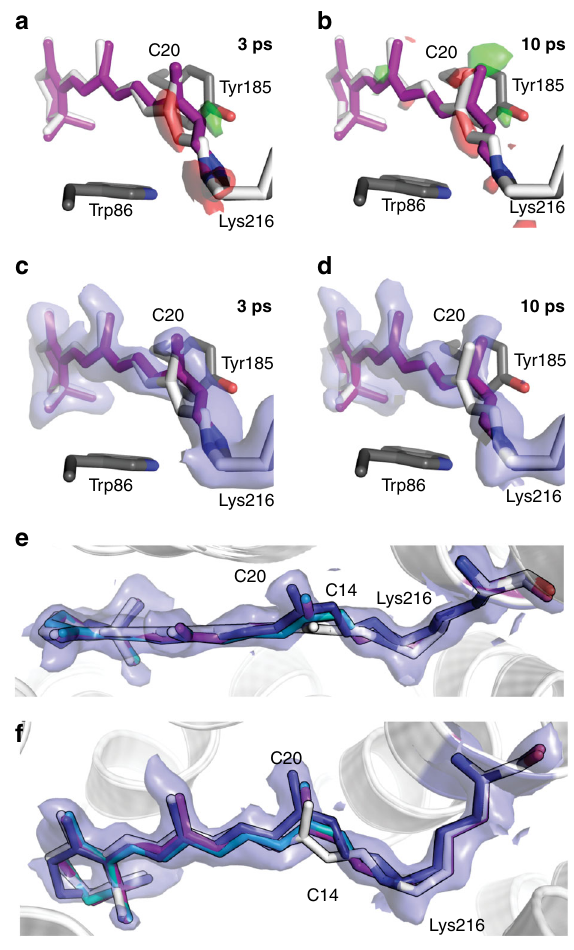
Fig. 5 Structure of the retinal in bacteriorhodopsin on the ps timescale. a View along retinal at time delays of 3 ps ( a , c ) and 10 ps ( b , d ); the retinal is shown in purple and the dark-state structure as white sticks. Extrapolated electron difference maps (green, + 3 σ and red, − 3 σ ) show clear deviations from the dark-state structure at the C20 methyl group as well as around the C13 = C14 bond. Both the C20 methyl group and the C14 atom shift towards residue Tyr185 (shown as grey sticks). The 10-ps structure was re fi ned using geometric parameters from a quantum mechanical (QM)- optimized model resulting in a − 68 ˚ torsion angle, corresponding to a twisted 13- cis conformation of retinal. e , f Overlay of the unre fi ned QM model of the 10-ps time point with the electron density, the top view ( e ) and side view ( f ) of the retinal binding pocket are shown. Retinal dark state, 10 ps structure re fi ned with the QM model, unre fi ned QM model and 10 ps structure from Nogly et al. 10 are shown as white, purple, teal and deep blue sticks, respectively. Extrapolated electron density of the 10-ps time point is contoured at 1